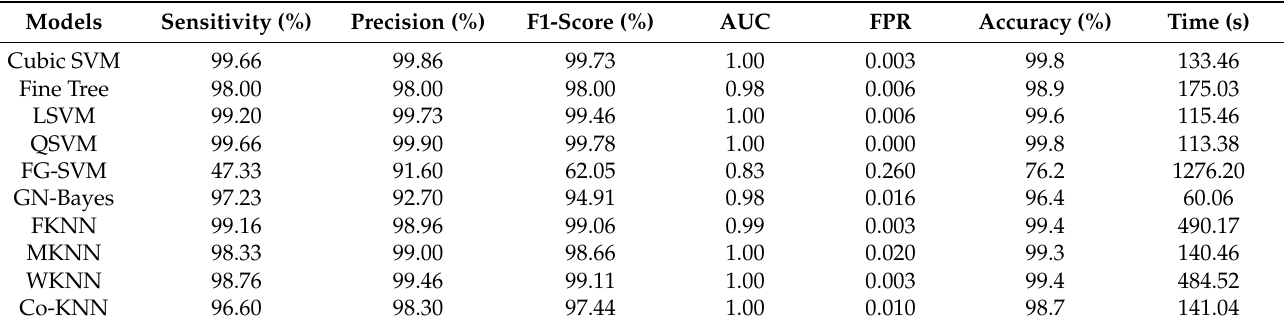
Table 12. Classification results using Fusion deep features for